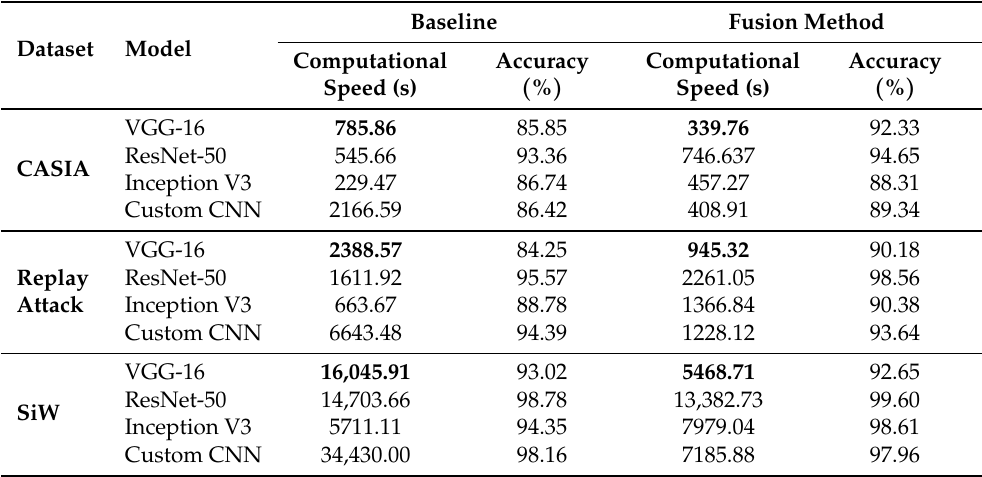
Figure 8. ROC curve analysis for CASIA, Replay Attack, and SiW. The performance of FPAD using pre-trained and custom CNN models is shown in ( a – c ). Fusion method performance for respective datasets is presented in ( d – f ). Table 5. Computation speed V/s accuracy comparison between baseline and fusion methods (train- ing